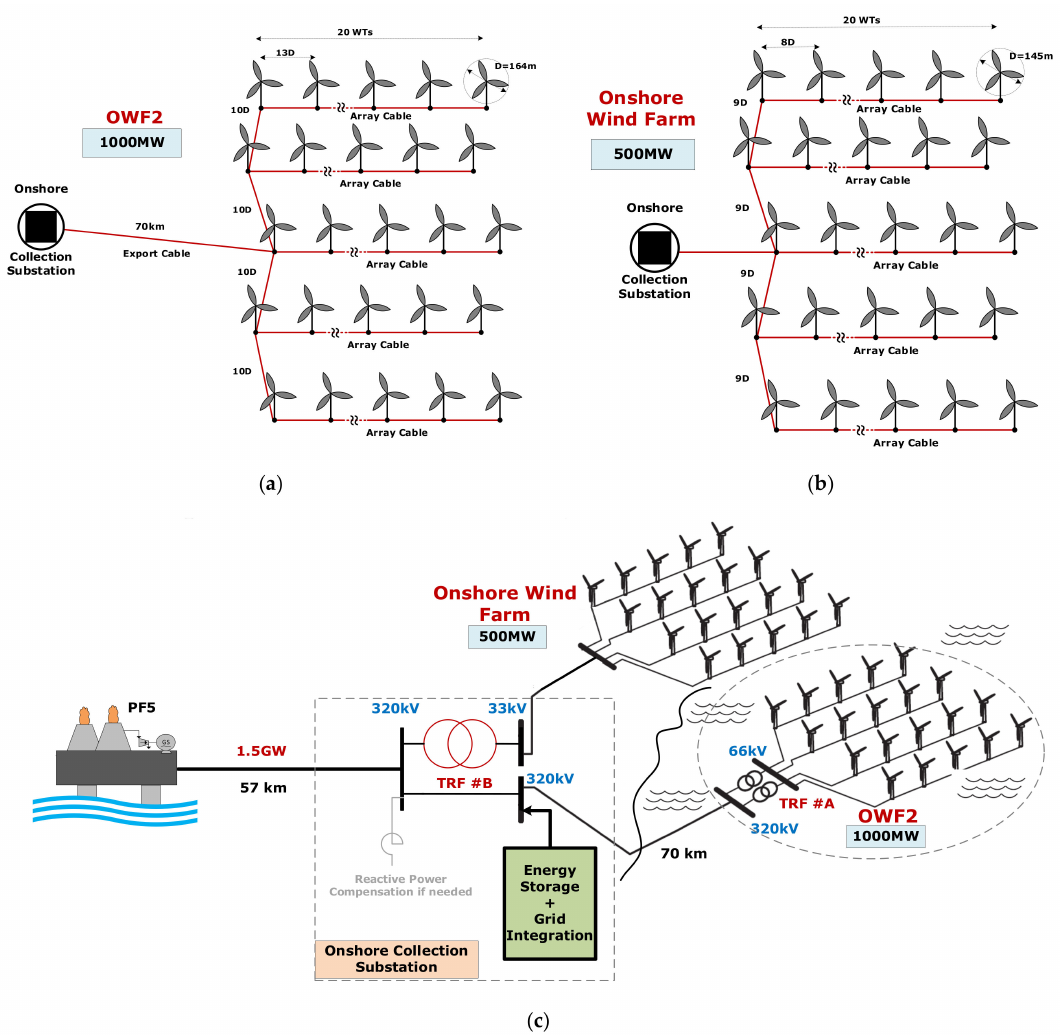
Figure 3. Case-2 wind farms’ layout and collection grid: ( a ) OWF WTs’ layout, ( b ) onshore wind farm WTs’ layout and ( c ) power collection layout.